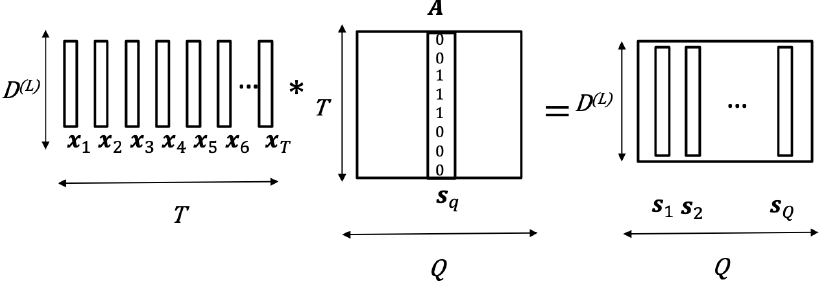
Figure 3. Process of alignment, the input signal x is multiplied by an alignment matrix A to produce a matrix with vectors s Q which are then concatenated to obtain the